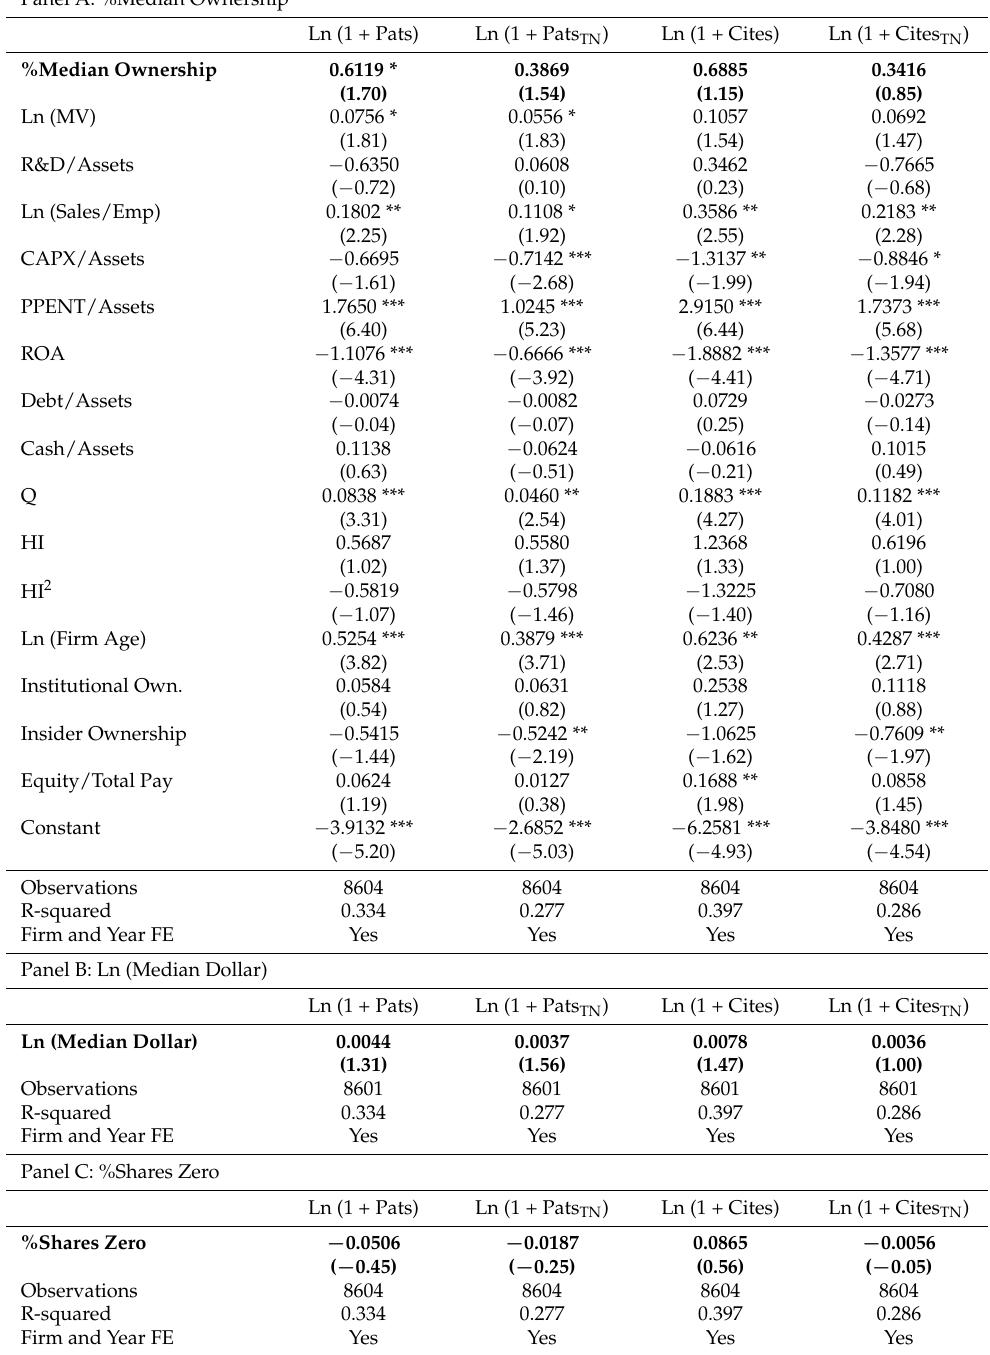
Table 9. Regressions of Innovation on Director Ownership. This table presents regression results of Innovation on various measures of Director Ownership. Panel A examines %Median Ownership, defined as the percentage ownership of the median director; Panel B examines Ln (Median Dollar), defined as the natural logarithm of the median dollar value of director ownership; Panel C examines Ln (Median Shares), defined as the natural logarithm of the median number of shares owned by directors; and Panel D examines %Shares Zero, defined as the percentage of directors on the board that owns zero shares. All except binary variables are winsorized at the upper and lower 1% levels. Full variable definitions are provided in the Appendix A. T-statistics are reported in parentheses. Standard errors are adjusted based on the Huber–White sandwich estimate of variances and are clustered by firm. *** indicates significance at the 1% level, ** 5% and * 10%. Panel A: %Median Ownership Ln (1 +